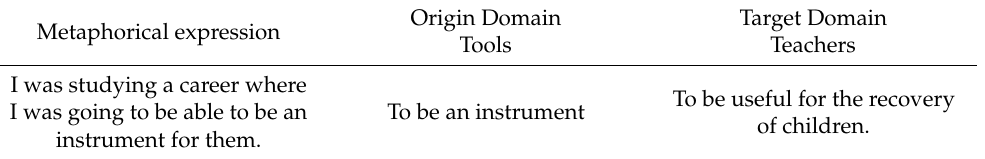
Table 13. Teachers are Tools.